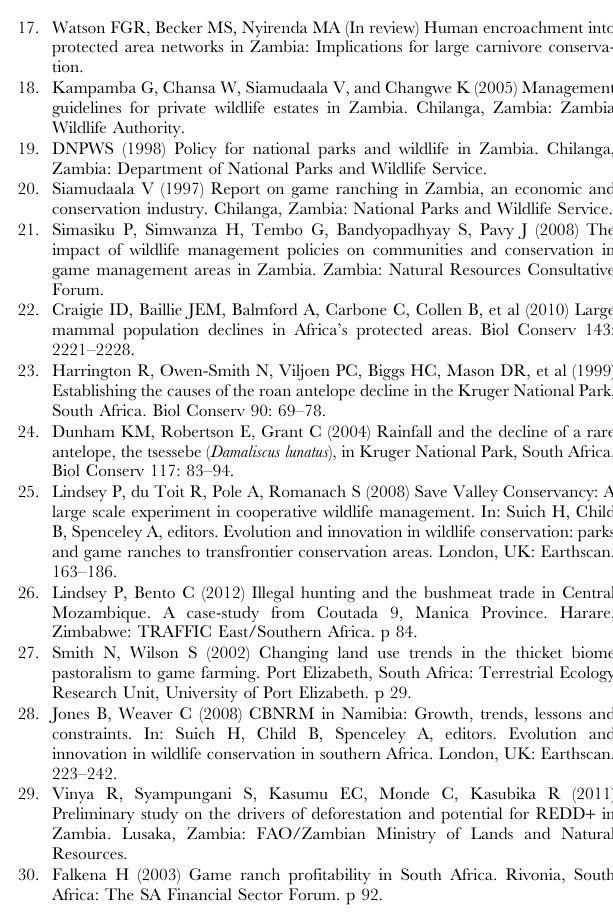
Table S4 Results of the financial and economic model for small-scale fenced game ranch of 20 km 2 (2012, annual figures given for year